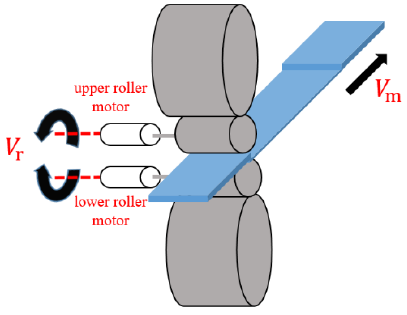
Figure 2. Hot rolling system configuration for velocity synchronization.